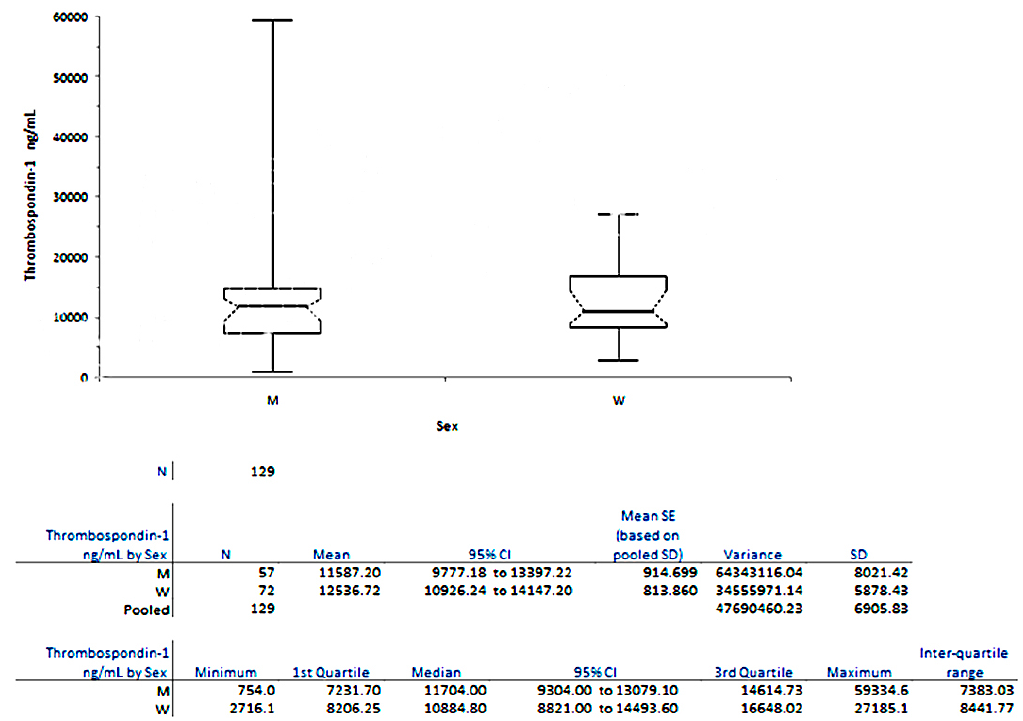
Figure 2. Variation of TSP-1 plasma levels in men and women in Group C.